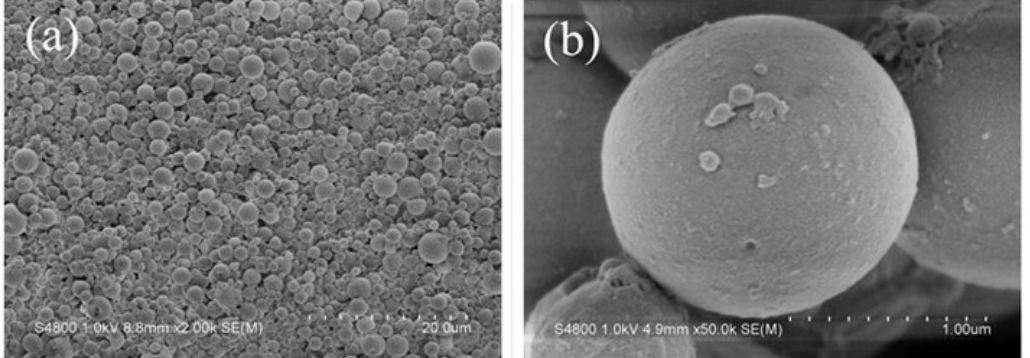
Figure 1. SEM images of polyamine microsphere: ( a ) Image of an aggregation of microsphere; ( b ) Magnification of an intact microsphere; ( c ) Zoom-in image of the outer surface of microsphere; ( d ) Image of the microsphere obtained by reducing the adding amount of glutaraldehyde by